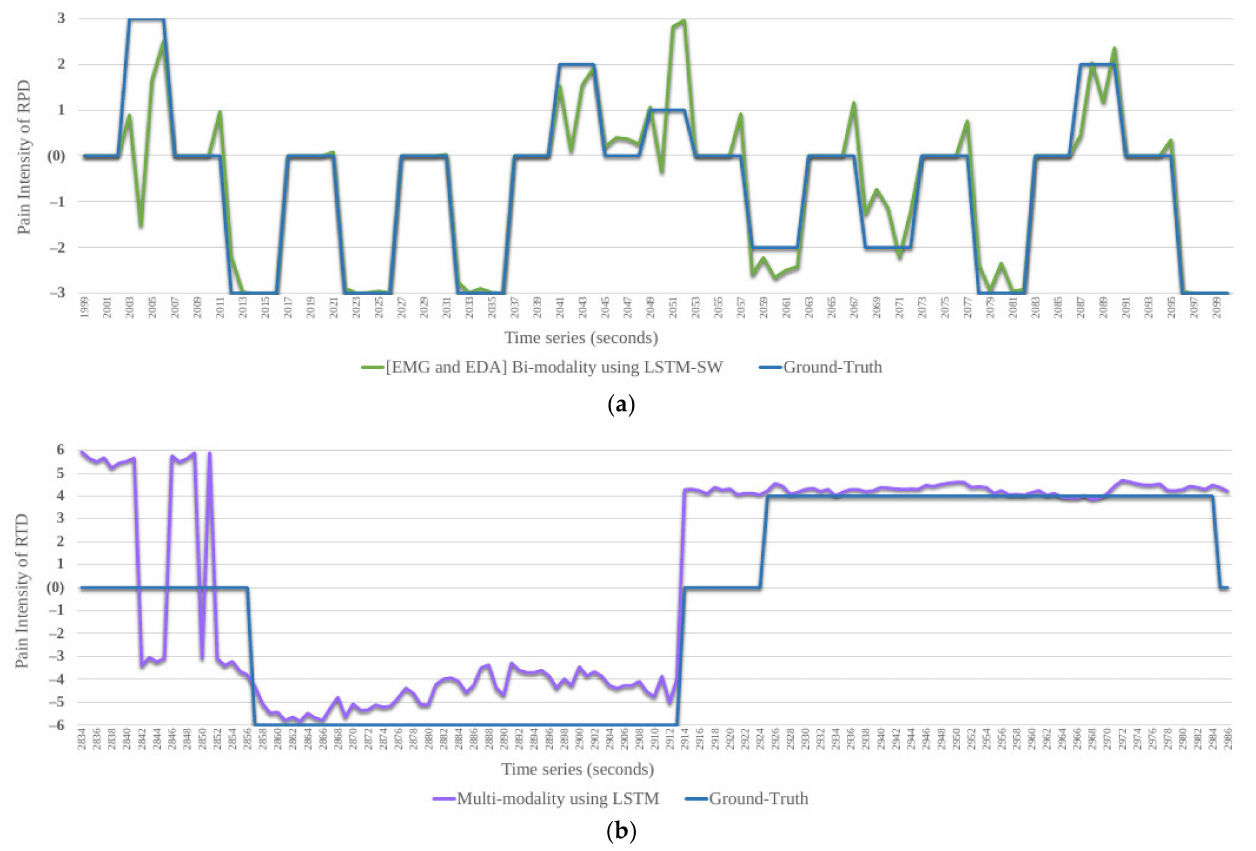
Figure 3. A performance example of the proposed automated system for continuous monitoring pain intensity from test set, including results of the best models with RPD (see ( a )) and RTD (see ( b )) compared to Ground − Truth. RPD: Reduced Phasic Dataset. RTD: Reduced Tonic